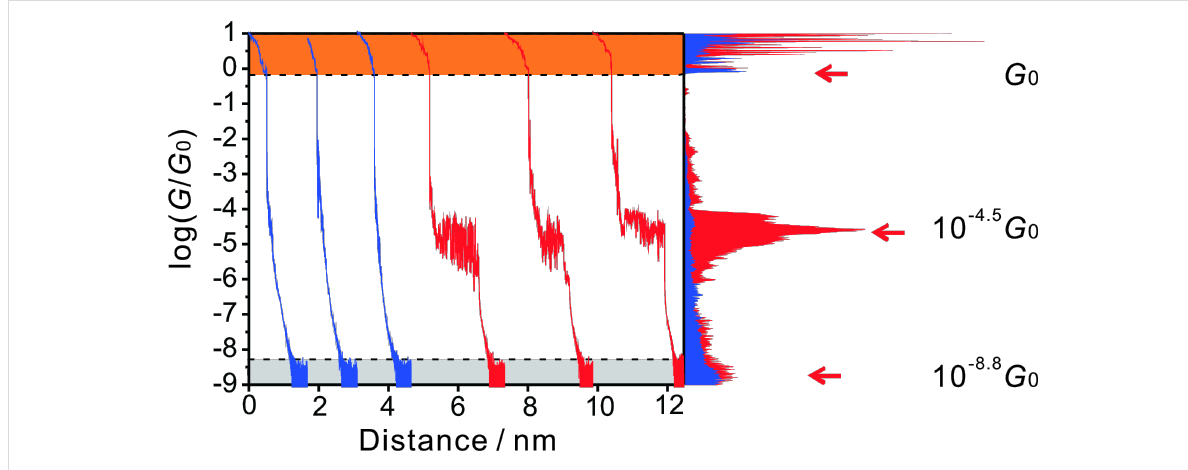
Figure 4: Individual conductance–distance traces and histogram constructed from these sets of three traces for AC at a bias voltage V bias = 0.10 V in THF/decane (v:v = 1:4) under Ar atmosphere. The most probable conductance is indicated.